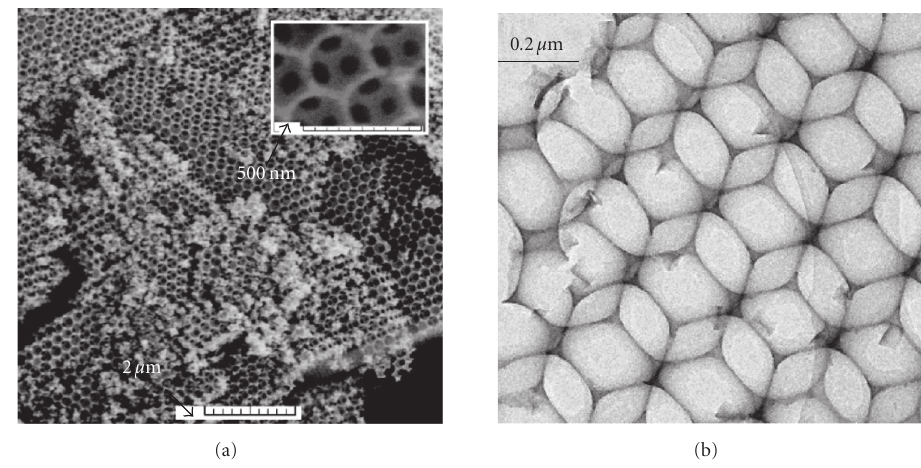
Figure 1: (a) SEM and (b) HRTEM michrographs of Ce-doped SG (Ce : Si molar ratio 1 · 10 − 3 ) inverted opals.